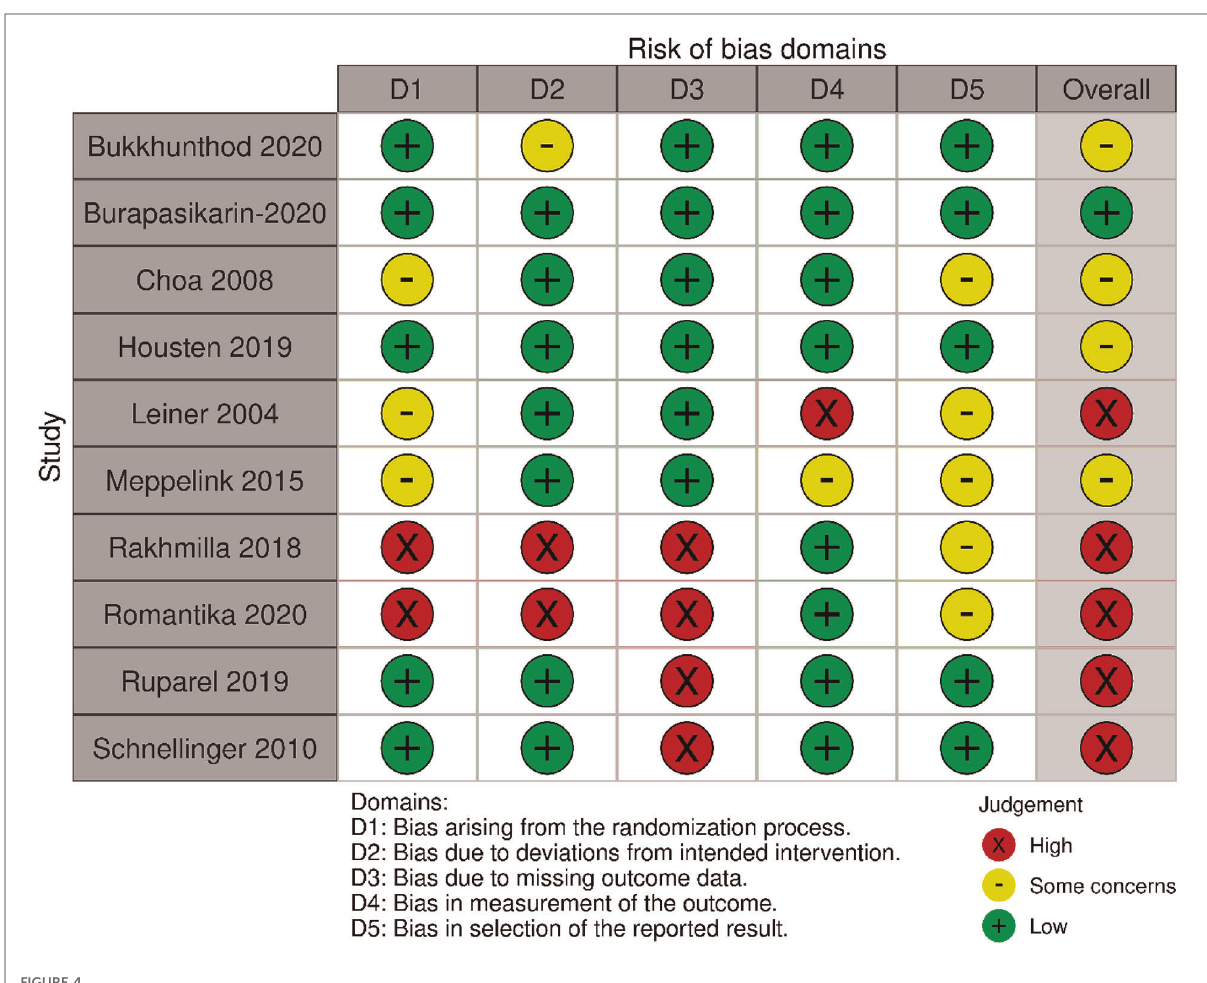
FIGURE 4 Risk of bias in the Category 3